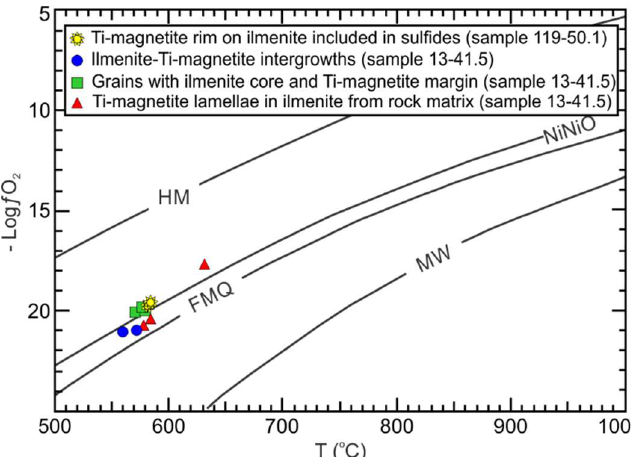
Figure 7. The estimation of equilibration temperatures and oxygen fugacities for three morphological types of ilmenite–magnetite mineral pairs from olivine metagabbro in the upper part of the Sedova Zaimka intrusion and also for ilmenite with magnetite rims from massive sulfides. The calculations were made using the models of Andersen and Lindsley [53], with corresponding program ILMAT [19]. Fugacity buffers are HM (hematite–magnetite), NiNiO (nickel–nickel oxide), FMQ (fayalite– magnetite–quartz), and WM (wustite–magnetite). Data from Table S1.